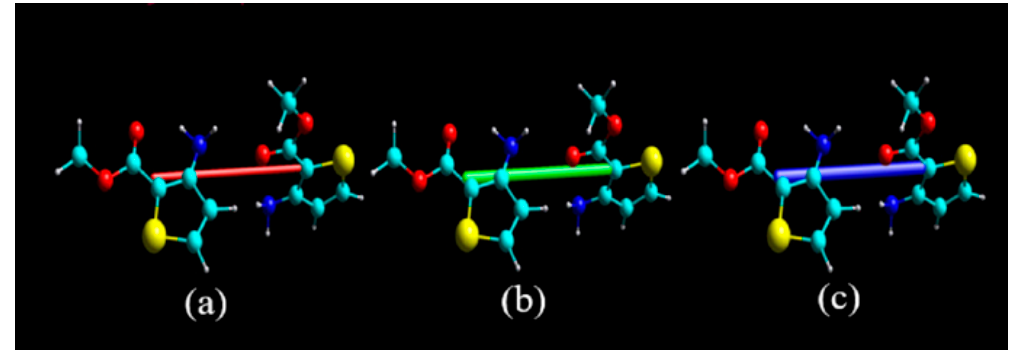
Figure 5. Typical energy-framework diagrams of matc along the b axis: ( a ) Coulomb interaction energies (red); ( b ) dispersion interaction energies (green); ( c ) total interaction energies (blue).